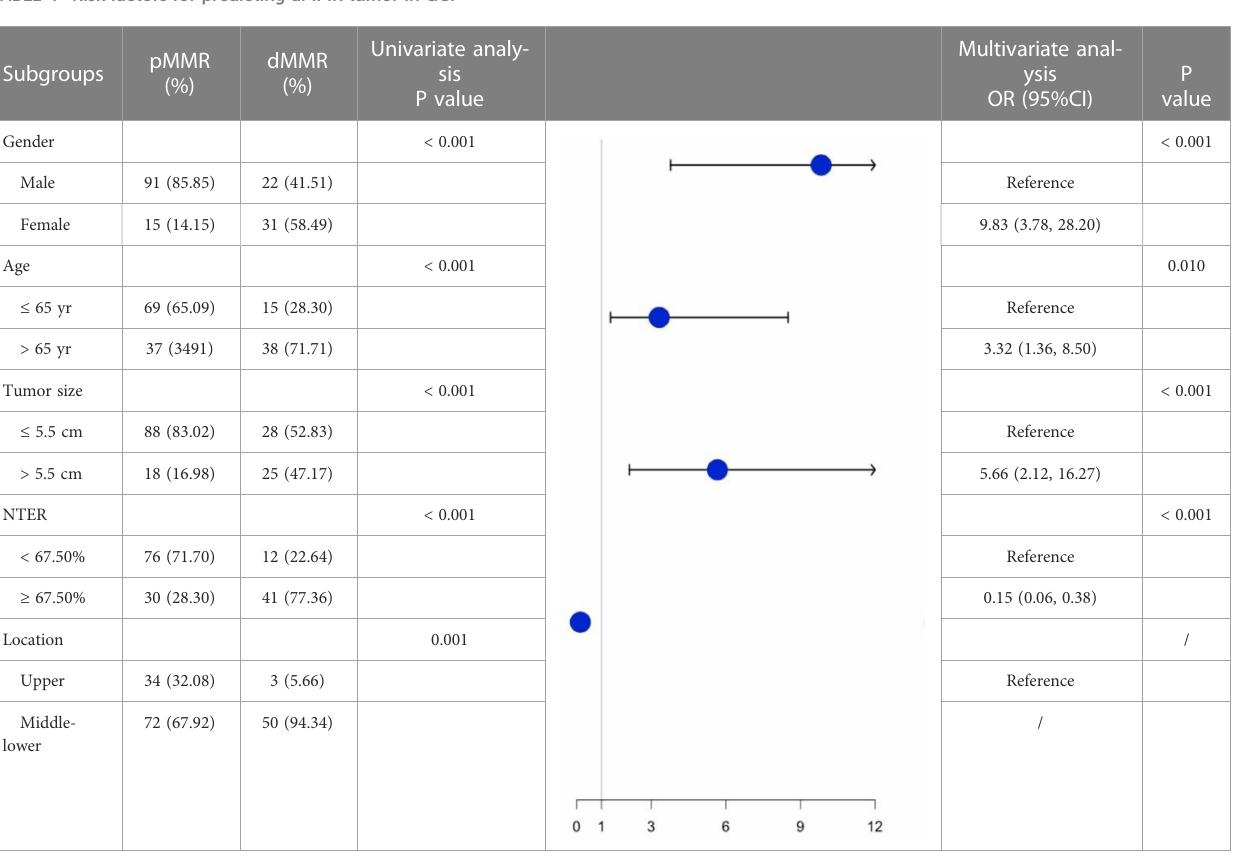
TABLE 4 Risk factors for predicting dMMR tumor in